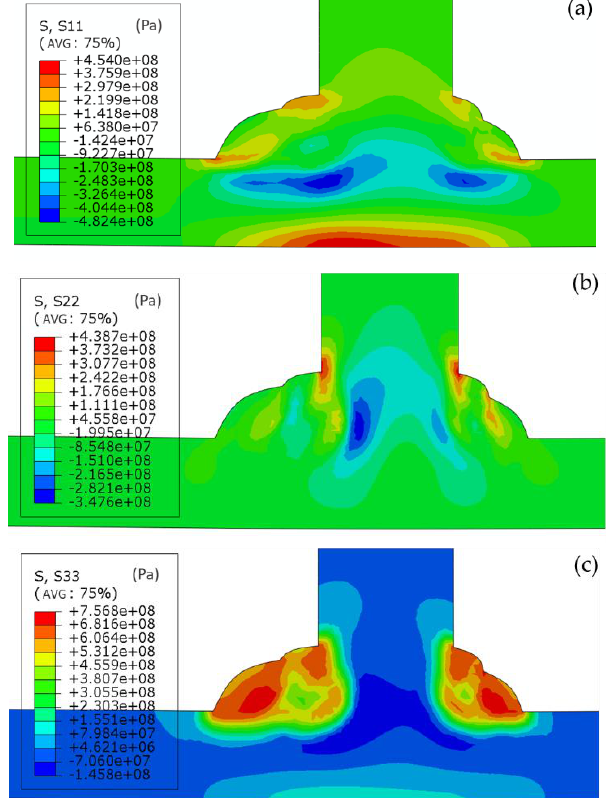
Figure 9. Residual stress distribution: ( a ) radial, ( b ) axial, ( c ) hoop.